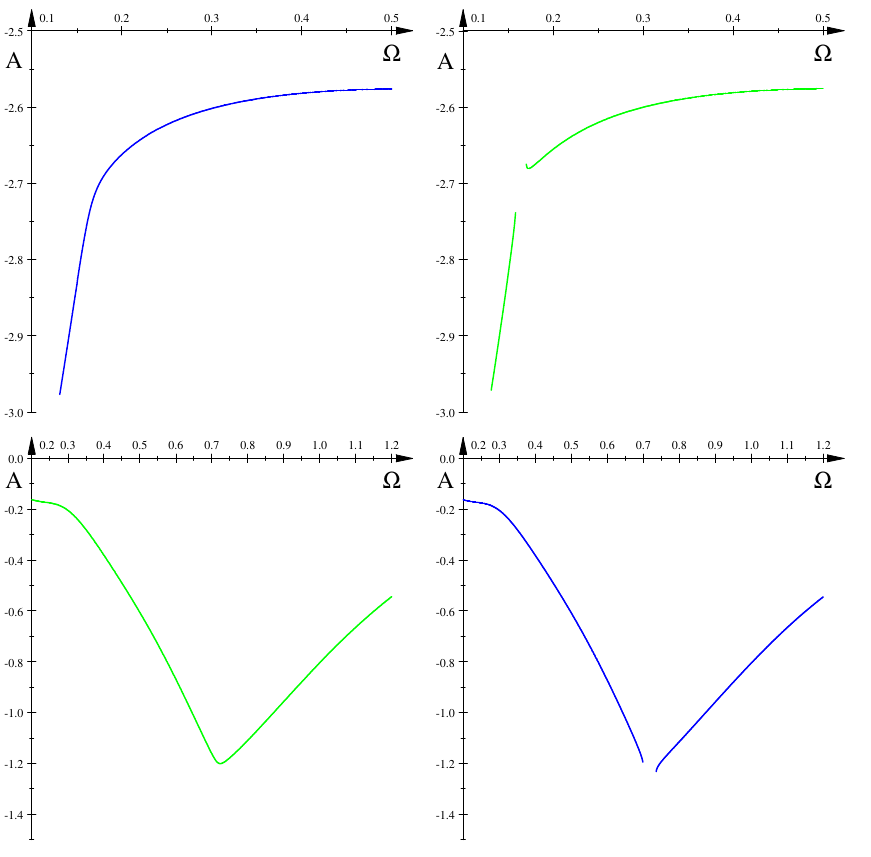
Figure 8. µ 0 = 1.1, ν 0 = 0.7978, G = 0.593—left top, G = 0.592—right top, µ 0 = − 1.1 (time inversion), ν 0 = 0.7978, G = 0.778—left bottom, G = 0.779—right bottom. In Figure 9, we show, for two different sets of values of parameters µ , ν , two examples of local contractions of the amplitude profiles to two isolated points for G → 0.